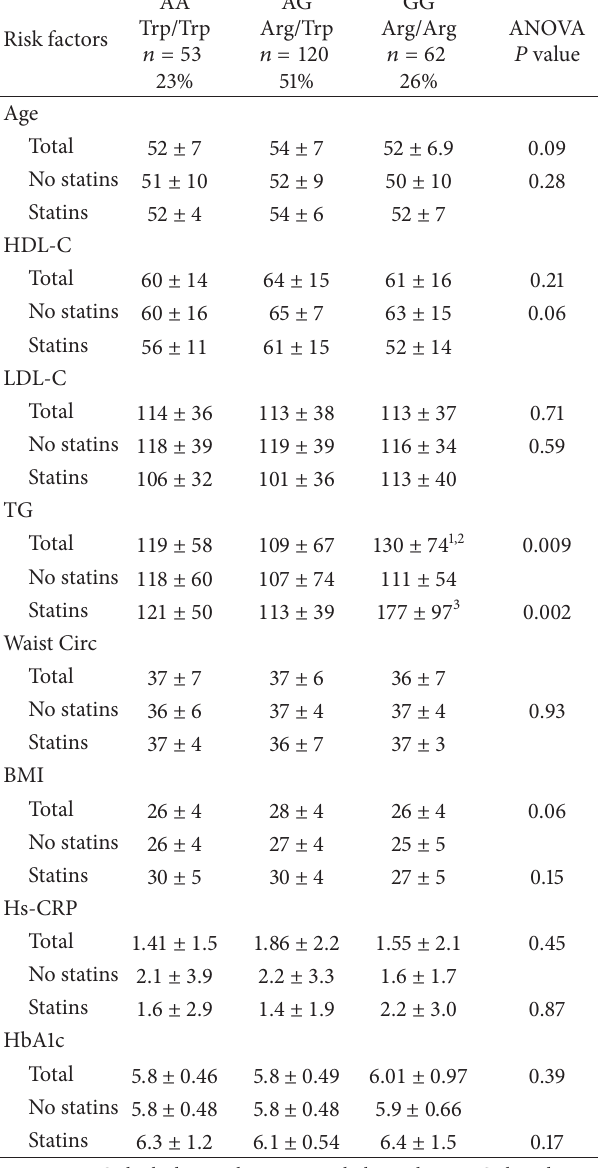
Table 3: Selective cardiovascular disease risk factors as a function of the rs20455 genotype and statin medication usage.